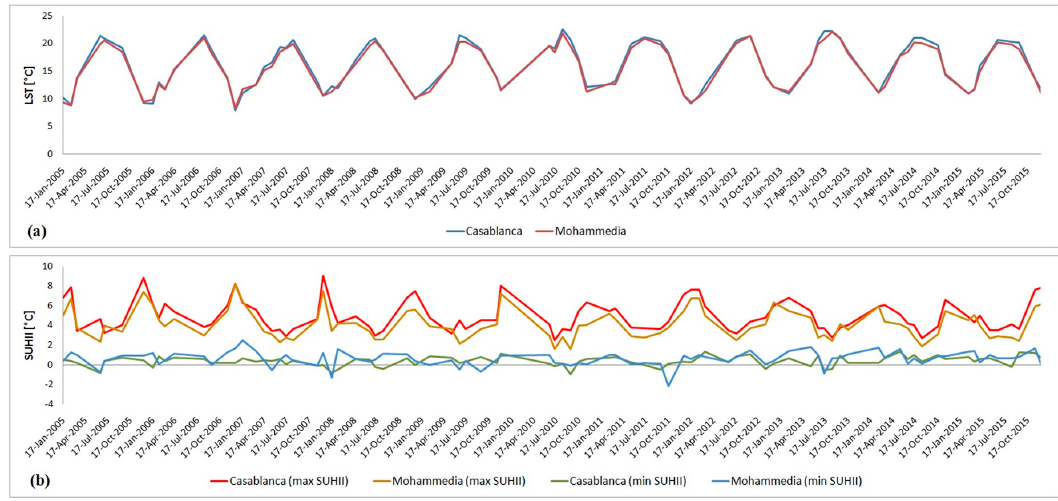
Figure 15. ( a ) Variation of average nighttime LST in Casablanca and Mohammedia between 2005 and 2015 (extracted from MOD11A2 data); and ( b ) variation of maximum and minimum nighttime SUHII in Casablanca and Mohammedia between 2005 and 2015 (evaluated from MOD11A2 data).